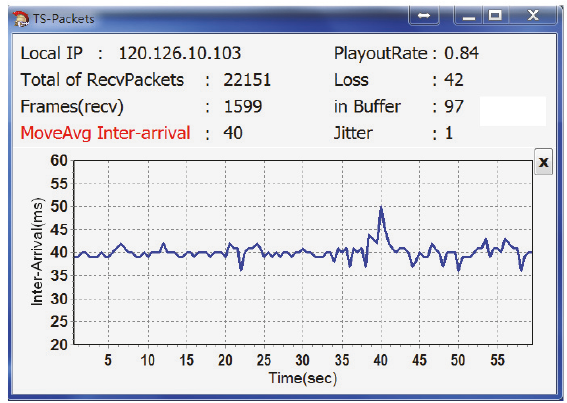
Figure 9. The server pumps the video stream into the first router, followed by a bottleneck link and the second router. Finally, the disturbed video stream arrives at the